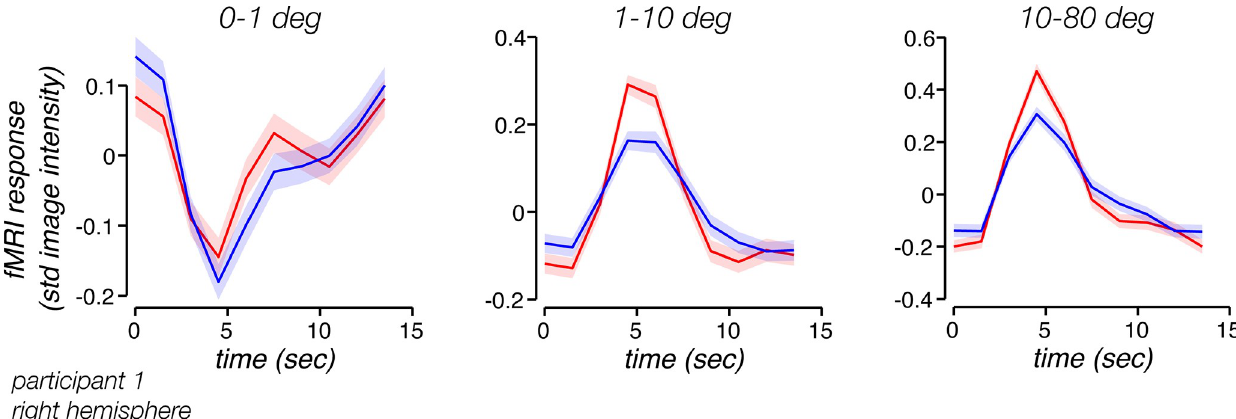
Fig 3. Task-related response as a function of visual eccentricity. fMRI responses in three subregions of EVC defined by visual eccentricities, for a representative participant (P1). Left, < 1 deg eccentricity; center, 1–10 deg eccentricity; right, > 10 deg eccentricity. Time series from EVC were averaged across all voxels within each bin and across all trials within high-reward (red) and low-reward (blue) runs. Shaded regions, ± SEM across trials. Underlying data can be found at https://osf.io/cbjq6/. EVC, early visual cortex; fMRI, functional MRI; std, standard deviation.